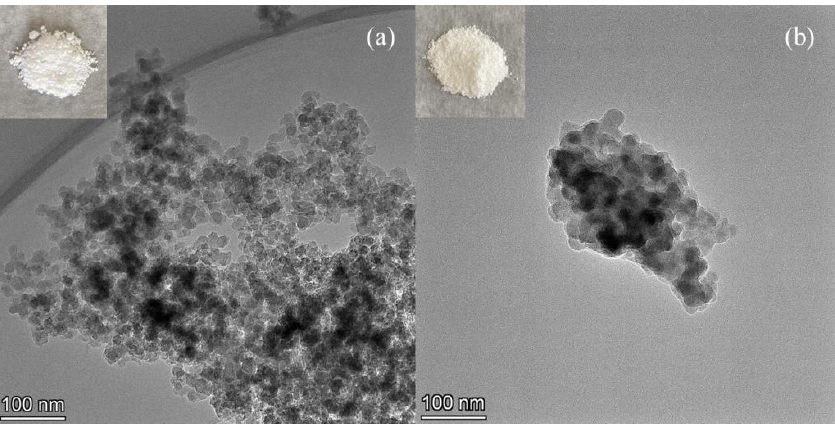
Figure 3. TEM images of ( a ) SiO 2 and ( b ) SiO 2 -g-PBA-b-PDMAEMA.